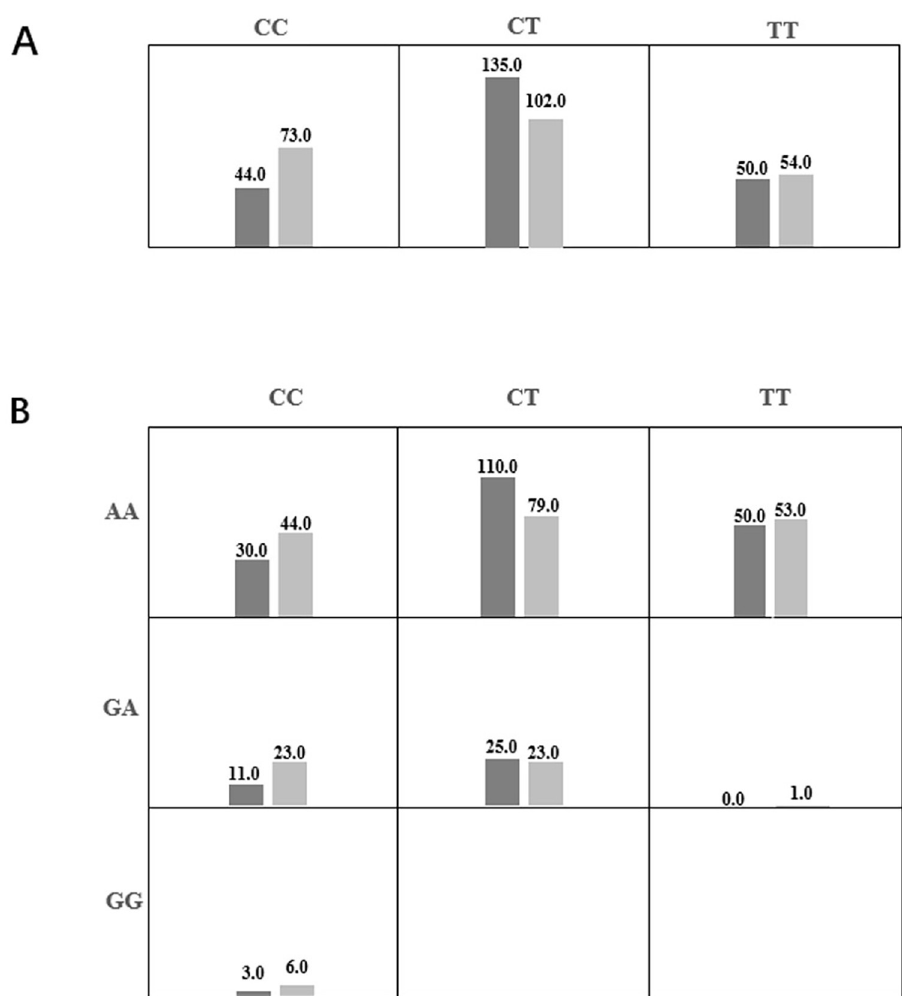
Fig 1. Summary of MDR gene-gene interaction. (A) S ingle-locus model. (B) Two-locus model. Each cell shows counts of “case” on left and “control” on